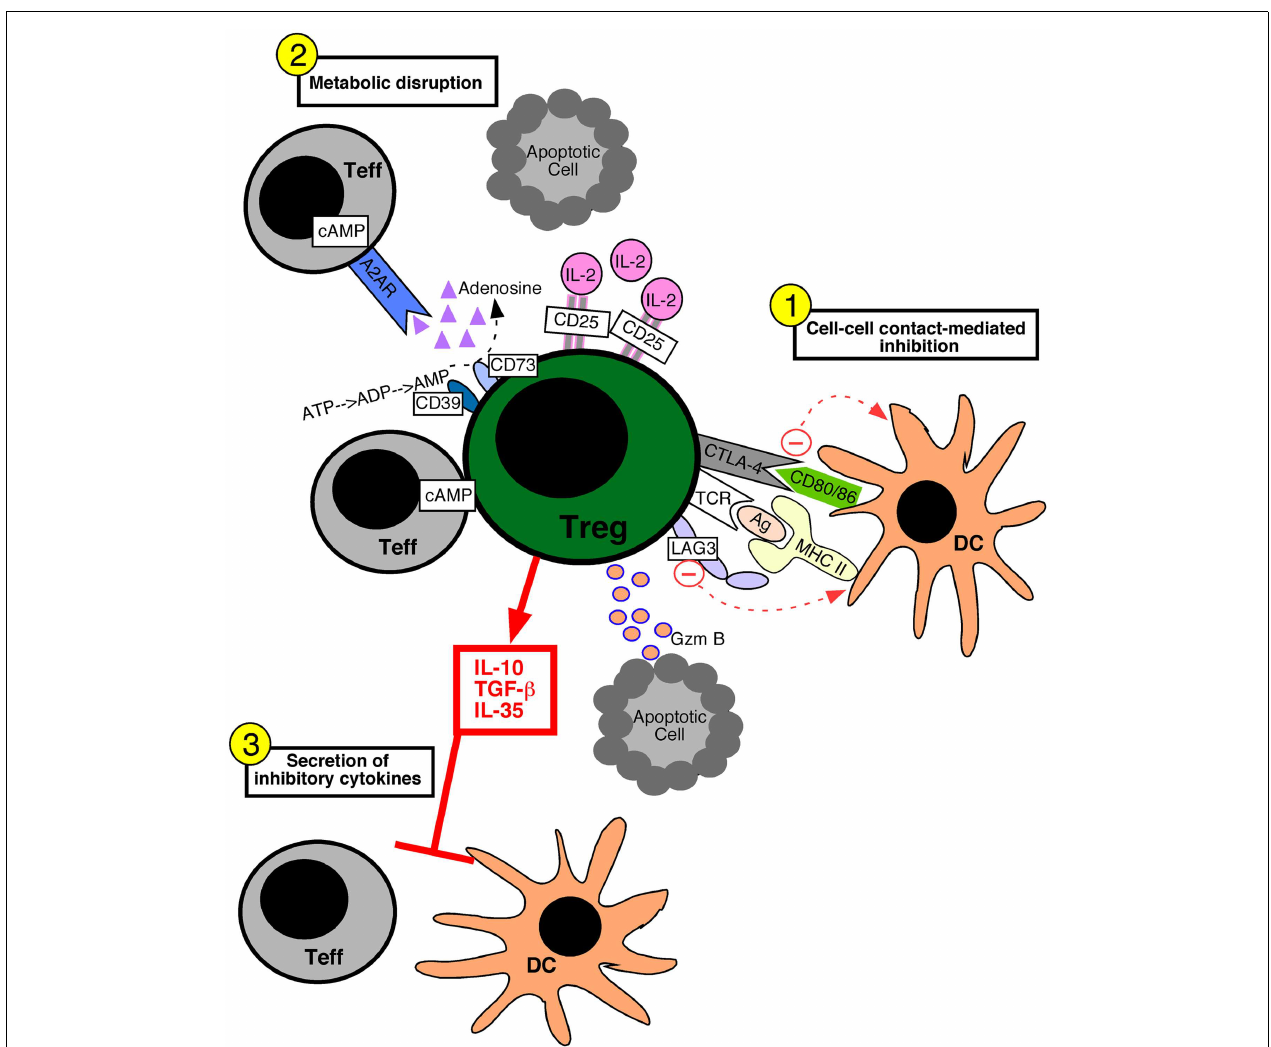
molecules on the DC, respectively. Delivery of granzyme B (Gzm B) toTeff cells leads to apoptosis. (2) Metabolic disruption of effectorT cells is mediated byTreg cell delivery of cAMP to effectorT cells via gap junctions, the generation of adenosine by theTreg cell ectoenzymes CD39 and CD73 which acts onTeff cell adenosine receptors (A2AR), and byTreg cell consumption of IL-2 thereby deprivingTeff cells of growth factors. (3)Treg cells secrete inhibitory cytokines such as IL-10, IL-35, andTGF- β 1, which inhibit bothT cells and